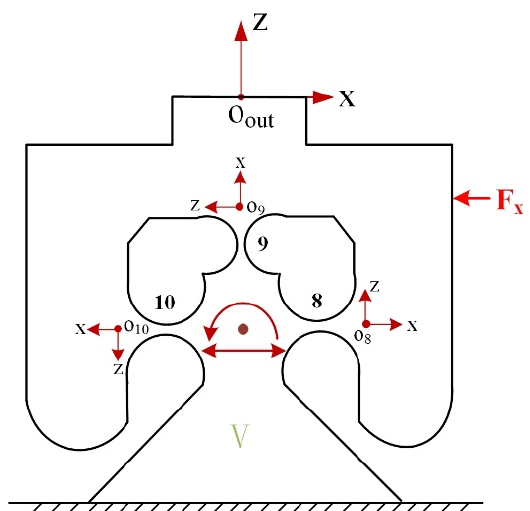
Figure 7. Schematic of the module V.